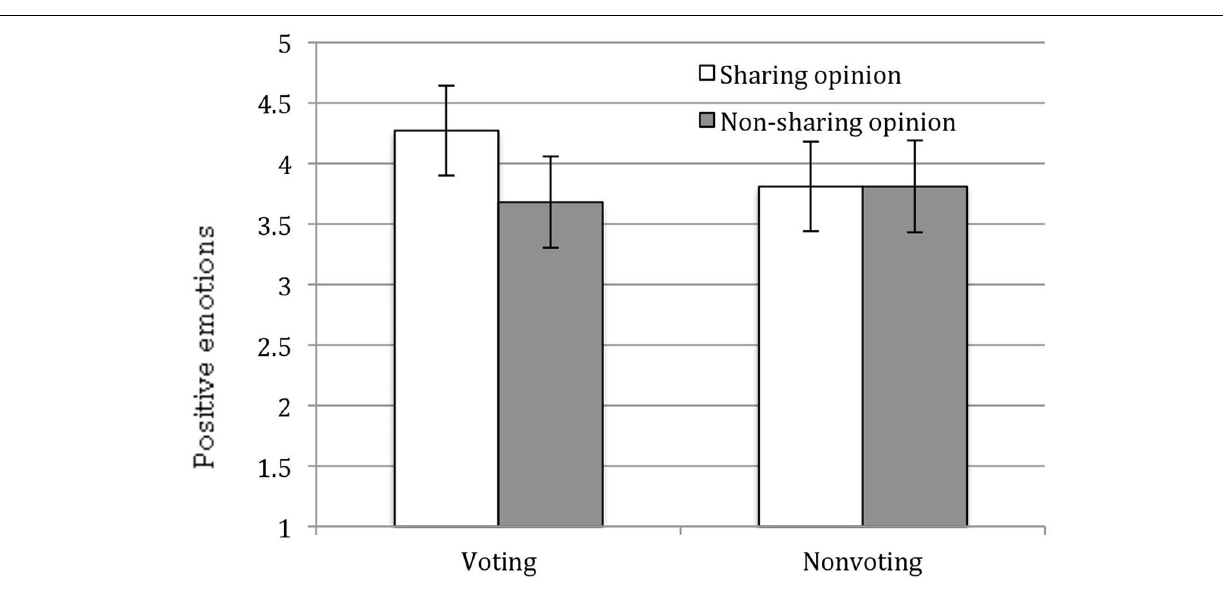
FIGURE 2 | Effect of voting or without voting and opinion sharing and without sharing on positive emotions, controlling gender and age (Study 2). Error bars represent 95% confidence